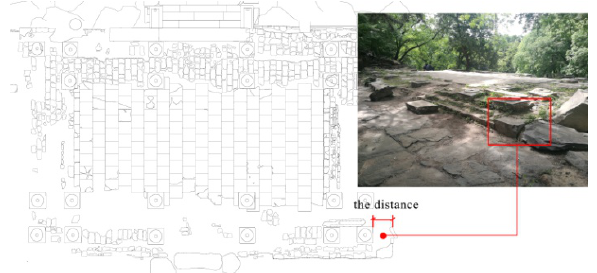
Figure 8. The Shanchu of Hanxiang Pavilion